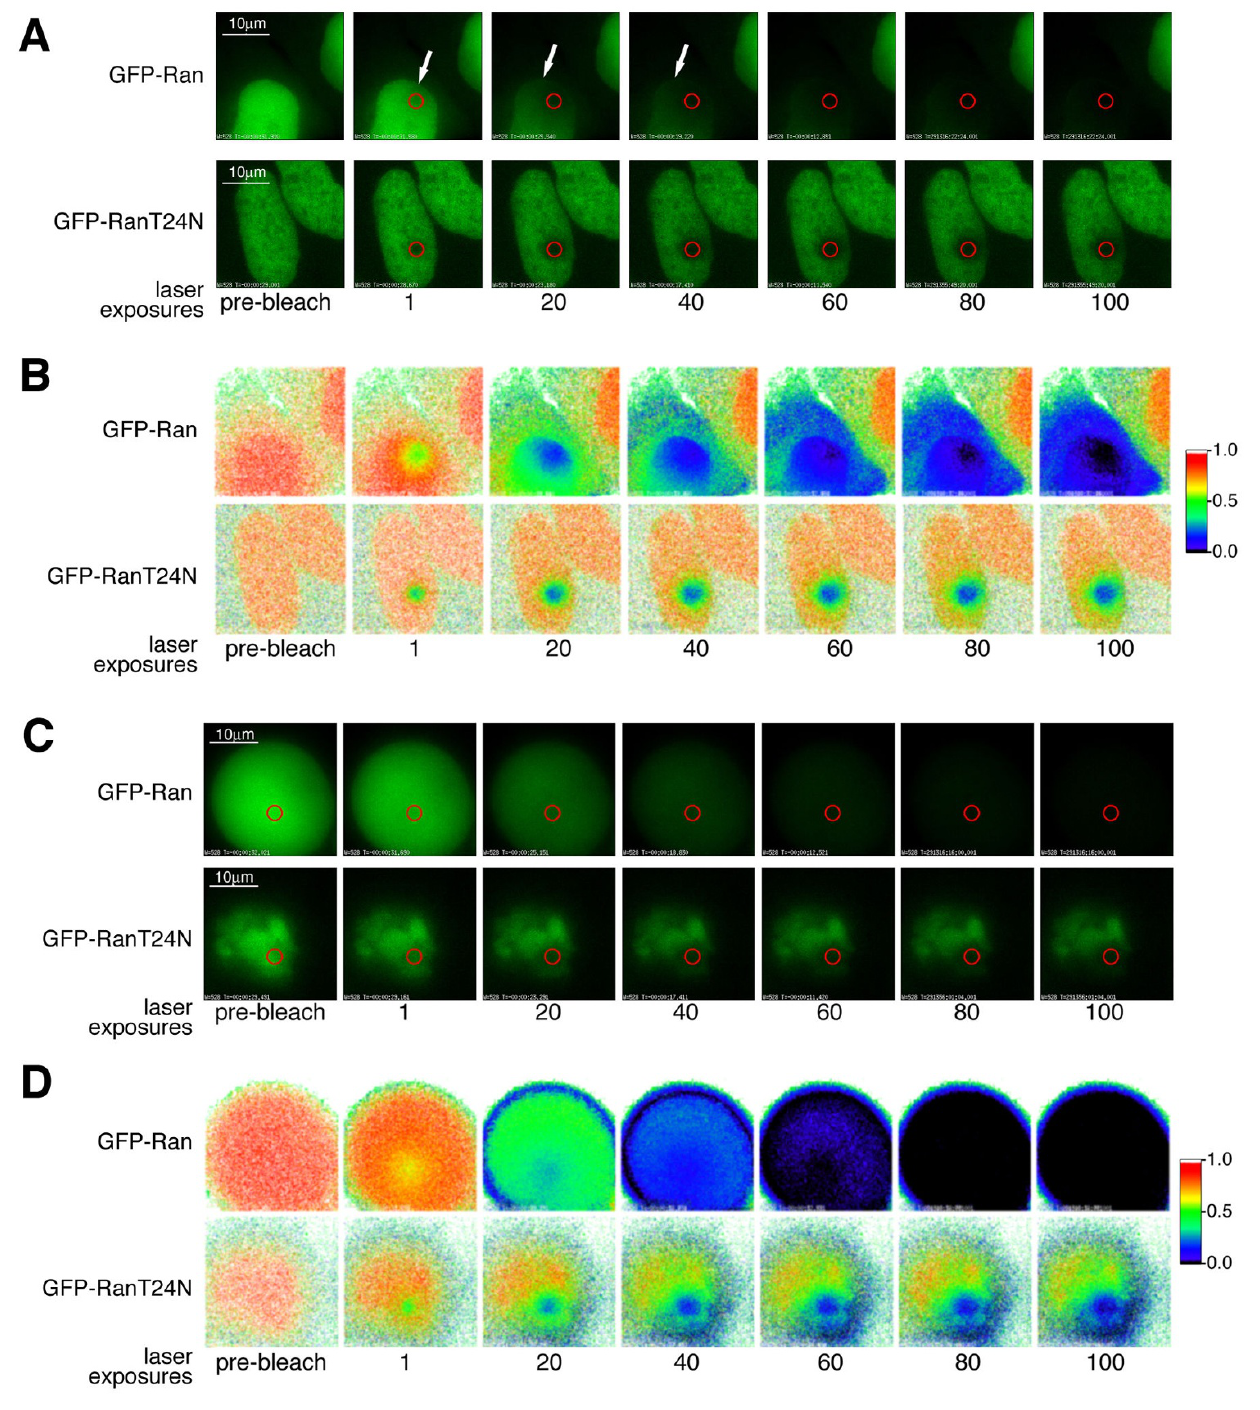
Figure 6 FLIP analysis of GFP-Ran WT and GFP-Ran T24N . Successive images of individual cells expressing GFP-Ran WT or GFP- Ran T24N in interphase (A) or mitosis (C) after photobleaching within a defined spot within the nucleus for the number of expo- sures shown. (B,D) False-colour imaging showing the relative change in fluorescence for the cells shown in (A) and (C), from orange through green to blue for increasing change, illustrating bleaching of the fluorescence